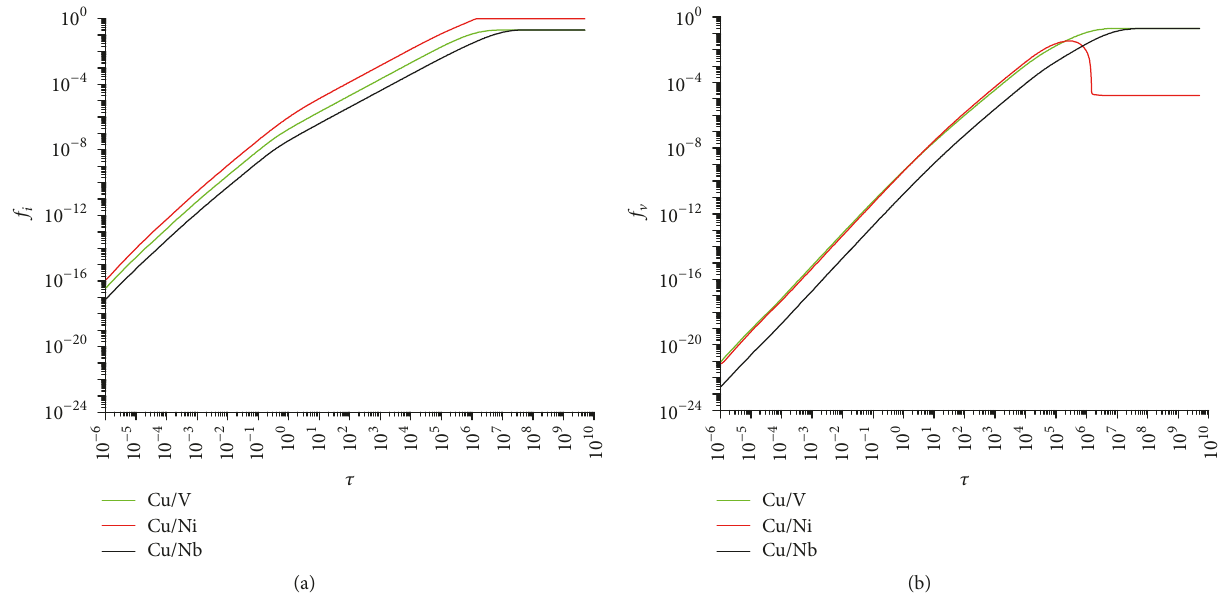
Figure 9: Temporal profiles of (a) SIA and (b) vacancy trap occupation probability at the interface between metals 𝛼 and 𝛽 .